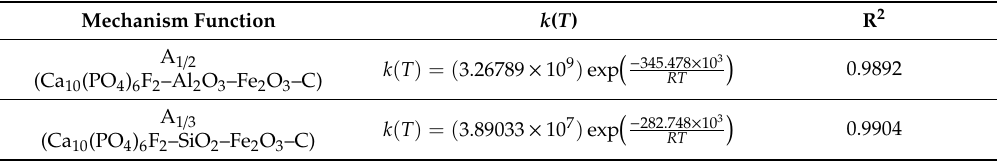
Figure 8. Linear fitting of ln k ( T ) versus 1/ T. Table 5. Kinetics parameters of apatite reduction.